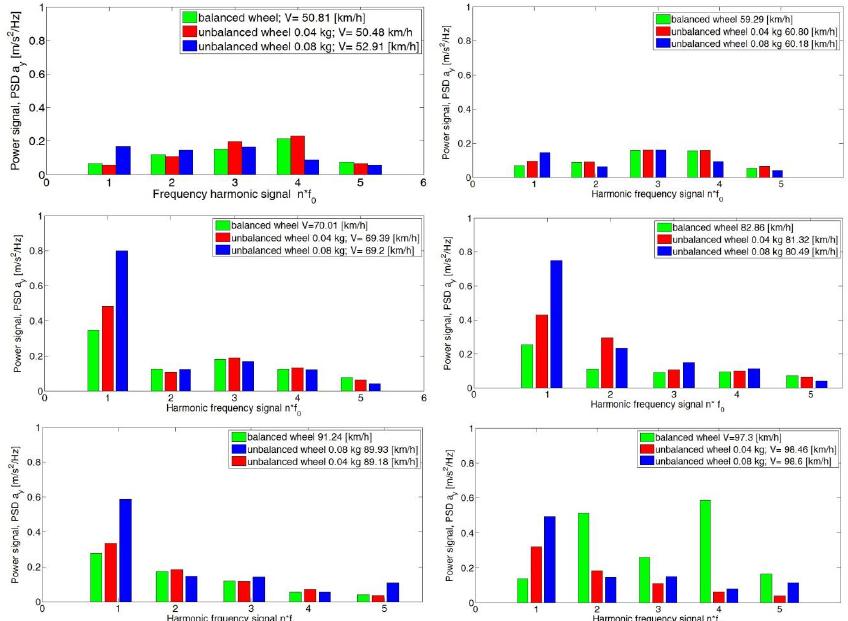
Figure 11. Signal power values of the analyzed harmonics of the y -axis for the adopted speed ranges for the road test.